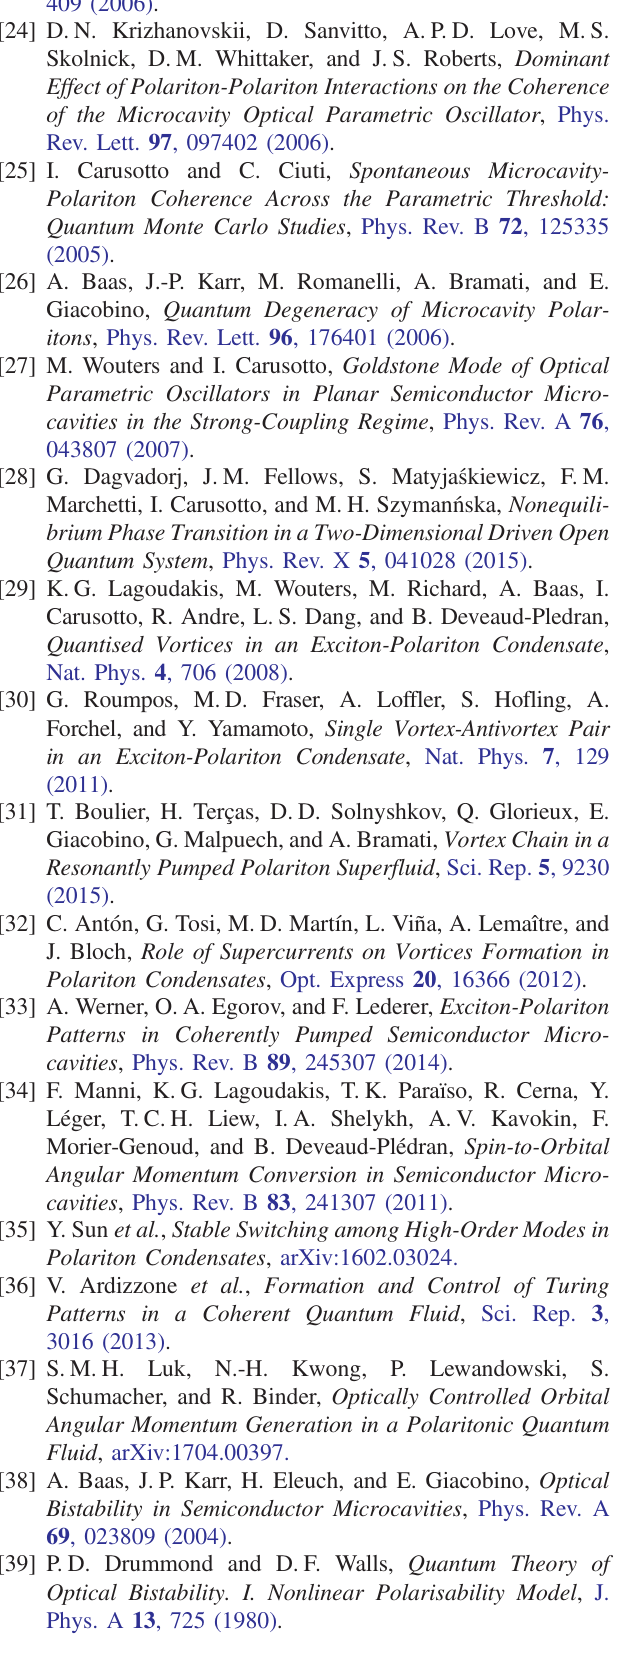
showing the full power dependence of patterns,